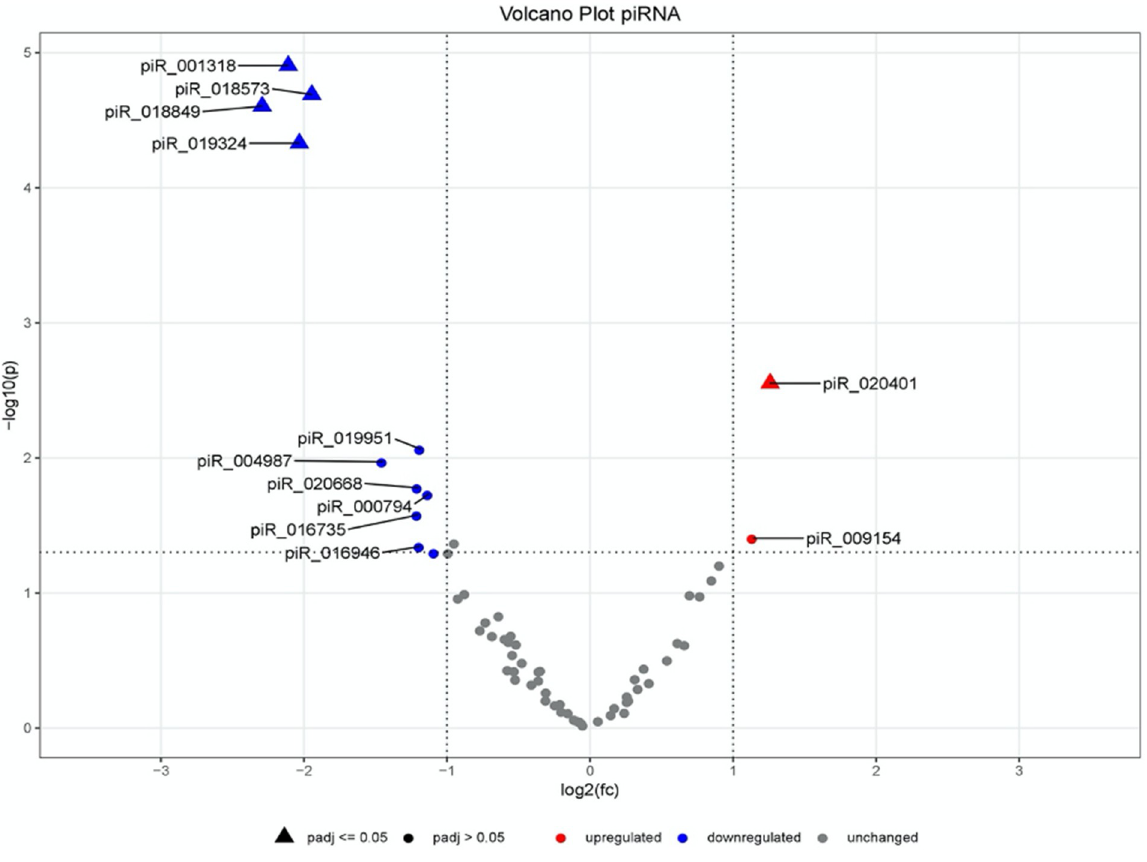
Fig 3. Volcano plot of the comparison of the piRNAs of PCa vs.